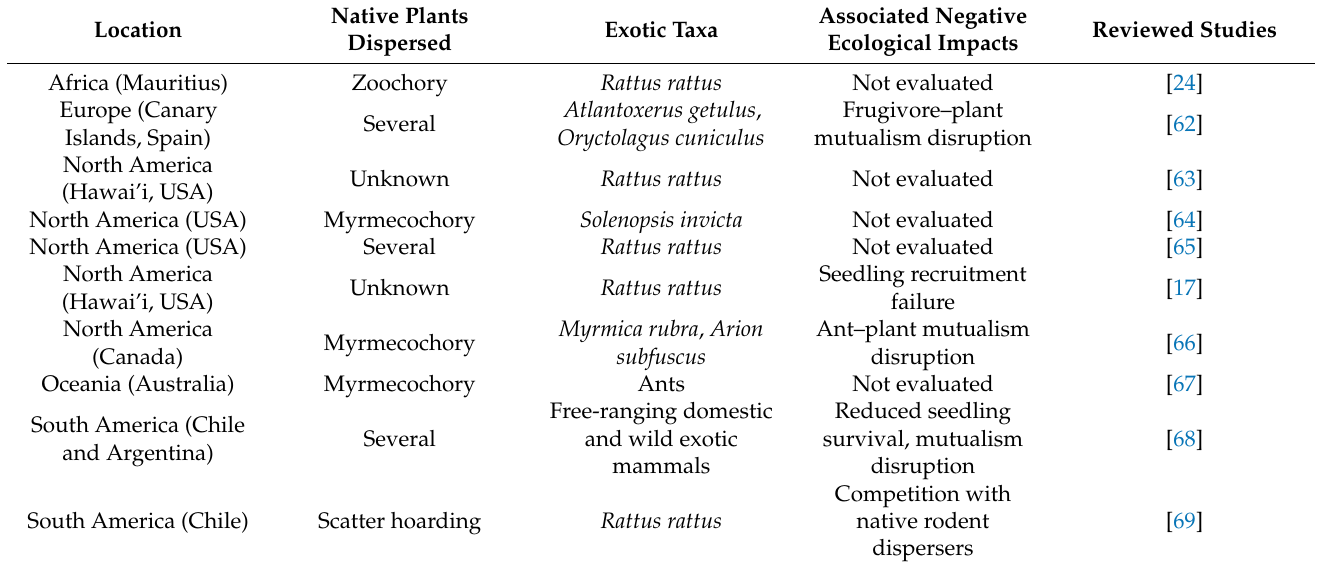
Table 3. Summary of the exotic taxa involved in native seeds predation and their additional ecological